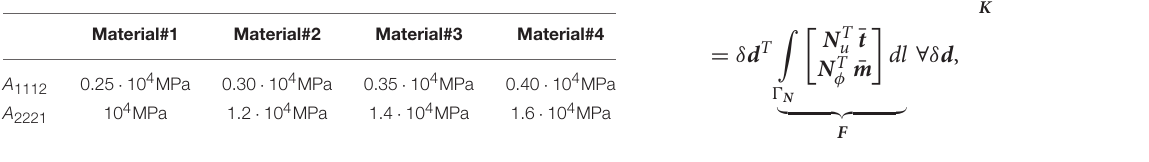
TABLE 4 | Mechanical properties used in Configuration 3